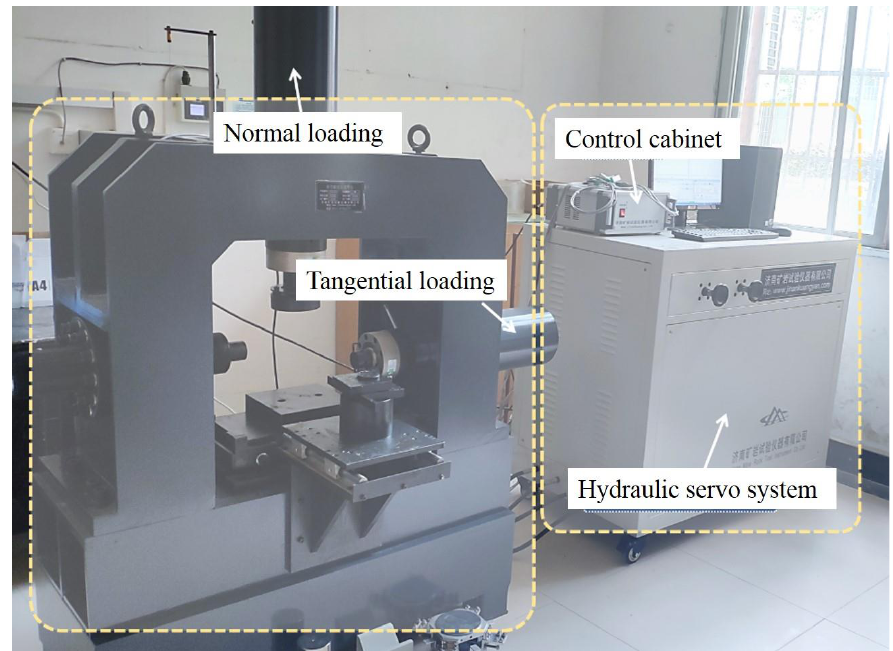
Figure 5. ZW100 multifunctional rock direct shear instrument.